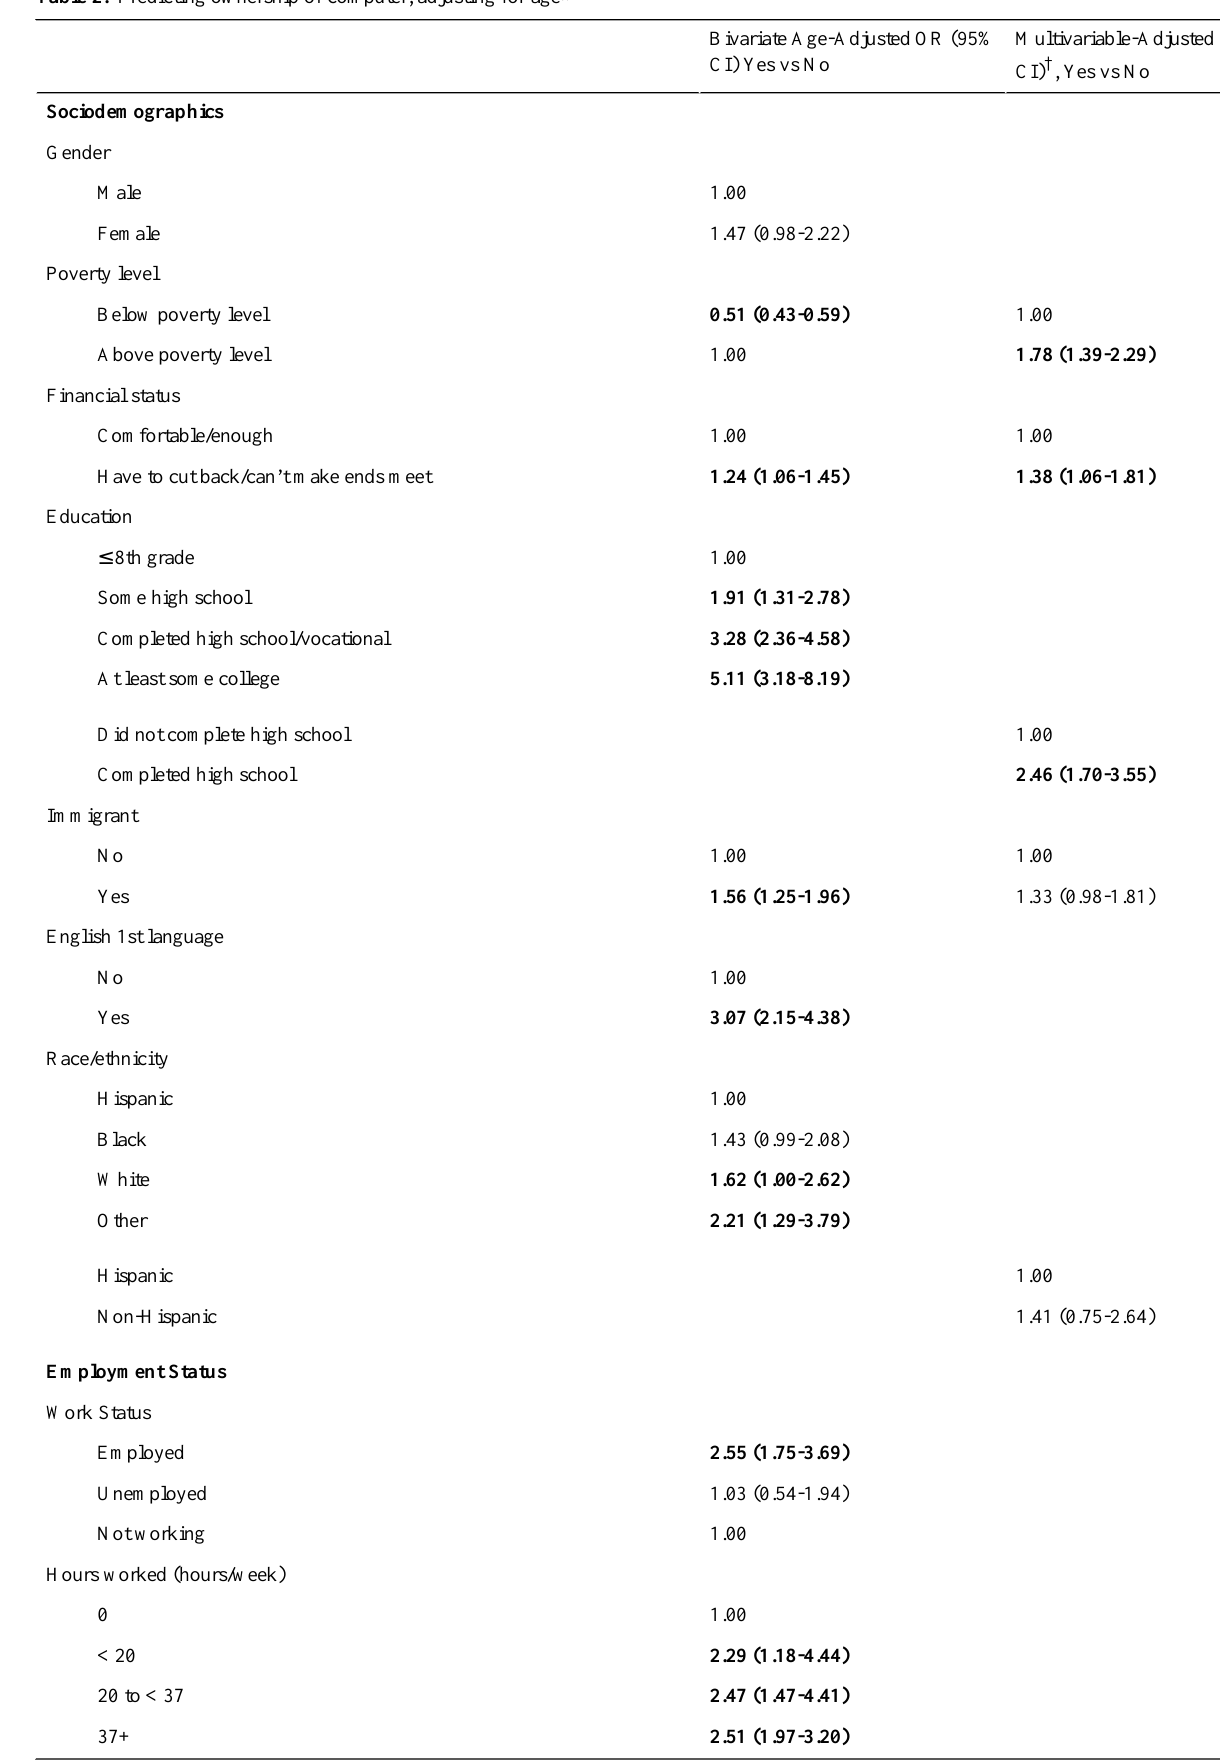
Table 2. Predicting ownership of computer, adjusting for age*